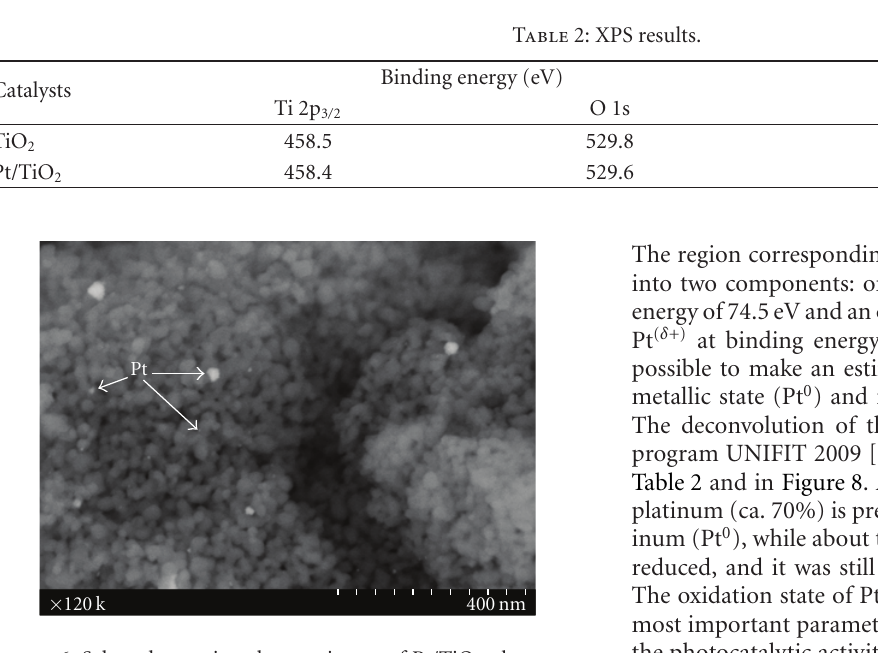
Figure 6: Selected scanning electron image of Pt/TiO 2 photocata-